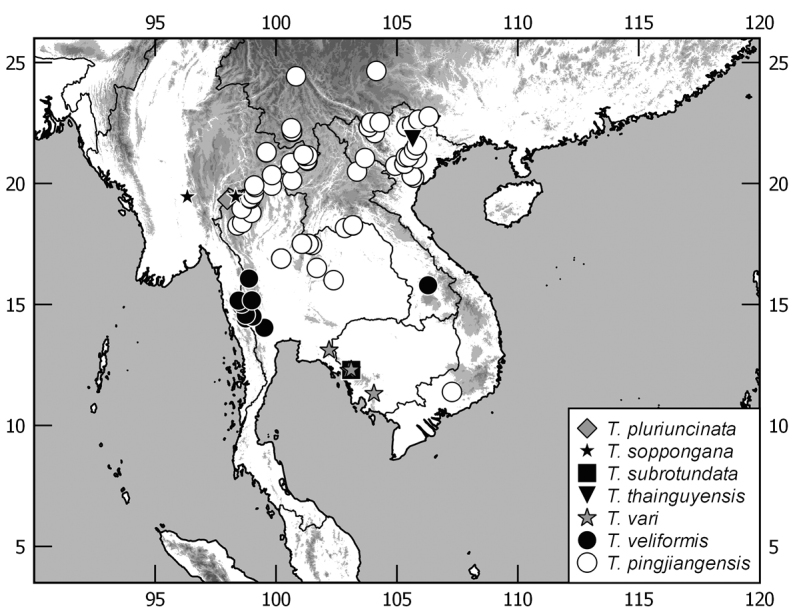
Distribution map of Tetrasericapingjiangensis Liu et al., 2014, T.pluriuncinata sp. n., T.soppongana sp. n., T.subrotundata sp. n., T.thainguyensis sp. n., T.vari sp. n., T.veliformis sp. n.